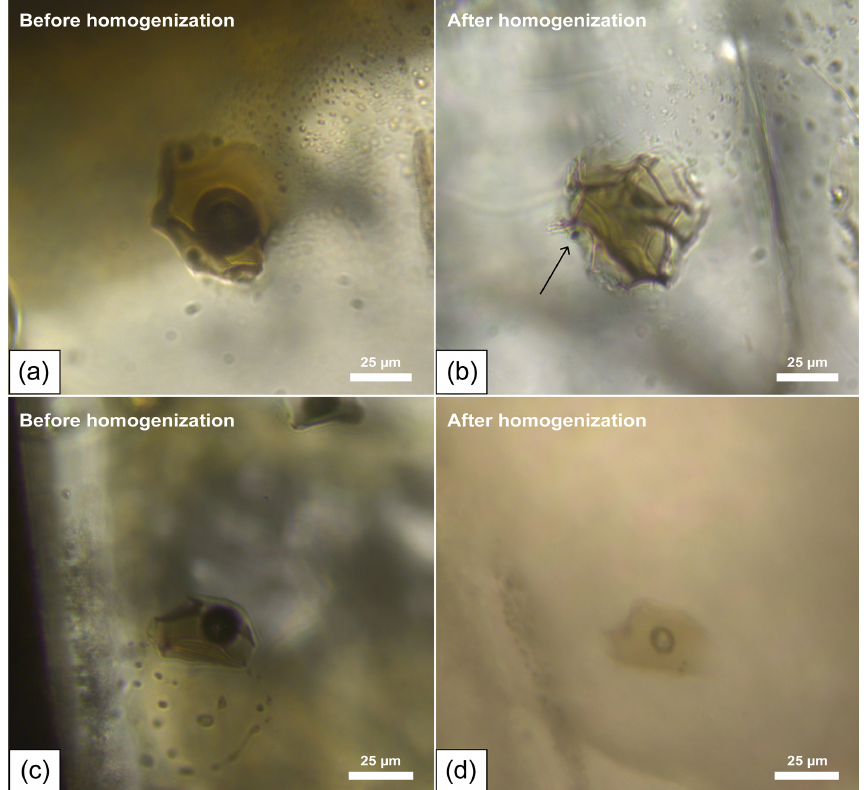
Figure 5. (a–b) Optical microphotographs of a melt inclusion before (a) and after (b) homogenization at 2.5GPa–1300 ◦ C–30min (HOP no. 3b-MIa). Note the complete disappearance of the bubble, which indicates that all the CO 2 initially stored in the bubble has been dissolved in the liquid. The arrow points to a small sulfide grain. (c–d) Optical microphotographs of a melt inclusion before (c) and after (d) homog- enization at medium pressure (1.5GPa–1300 ◦ C–30min; HOP no. 10a-MIb): the pressure was not sufficient to completely homogenize the inclusion, as shown by the persistence of a small CO 2 bubble.